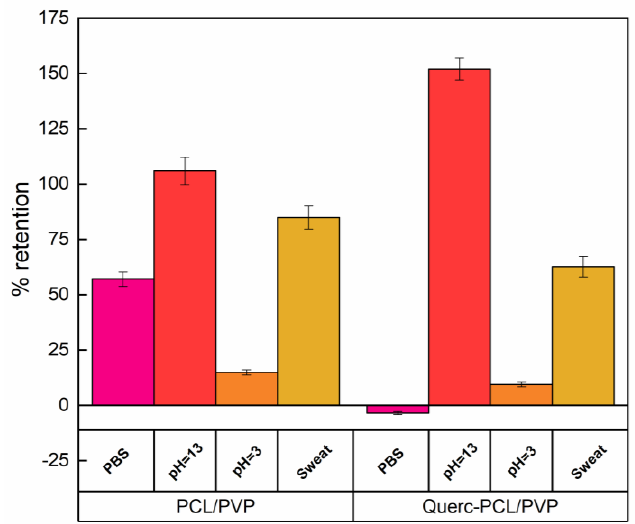
Figure 5. Liquid retention of electrospun membrane.